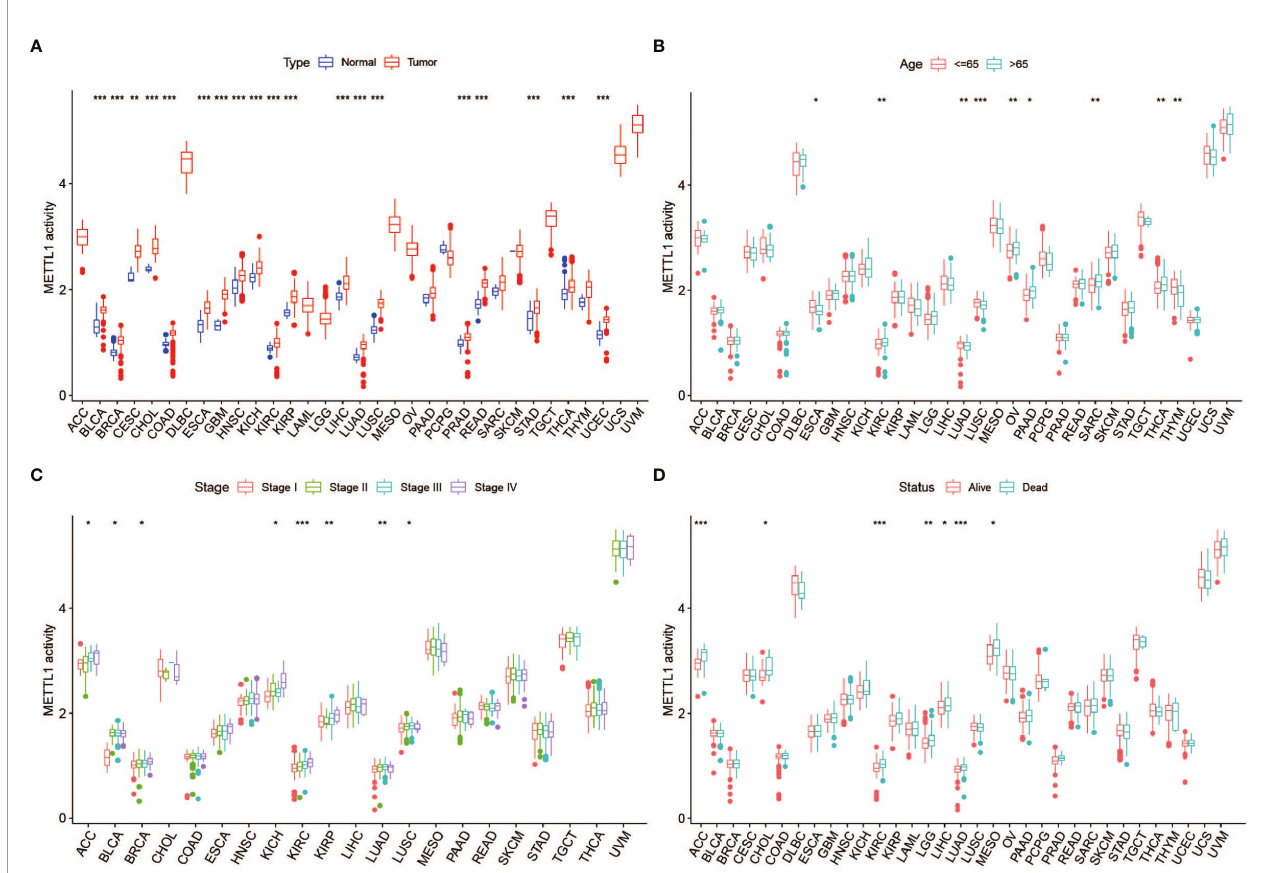
FIGURE 3 | Correlation between METTL1 activity and clinical traits. (A) The differential activity of METTL1 between normal and tumor tissues among pan-cancer. (B) The relationship between METTL1 activity and age. (C) The relationship between METTL1 activity and tumor stage. (D) The relationship between METTL1 activity and status. * means P < 0.05; ** means P < 0.01; *** means P <